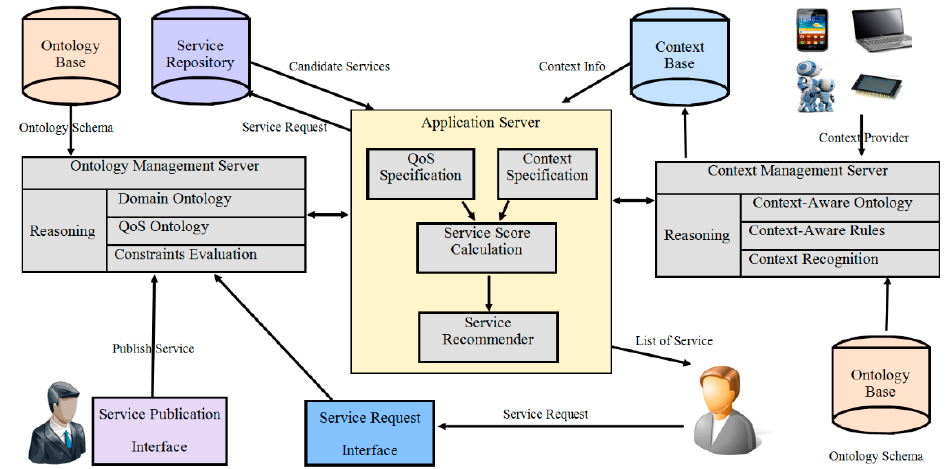
Figure 1. Semantic service discovery framework in a dynamic environment.